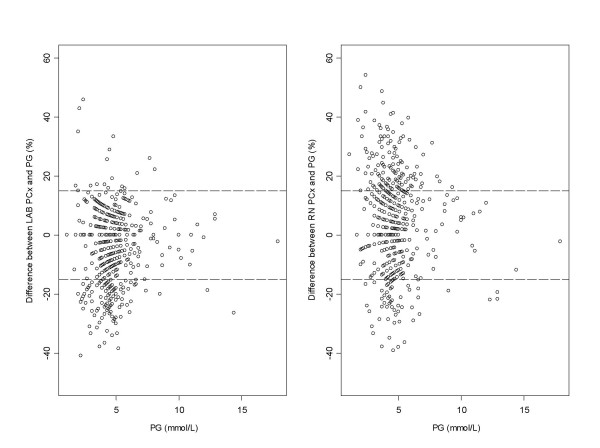
Comparison between PCx and PG measurements. Difference plots comparing glucose measurements on the PCx at the bedside (RN PCx) and in the laboratory (LAB PCx) with the corresponding glucose measurements on the laboratory analyser (PG). The two dashed lines represent the total error limits ± 15% .